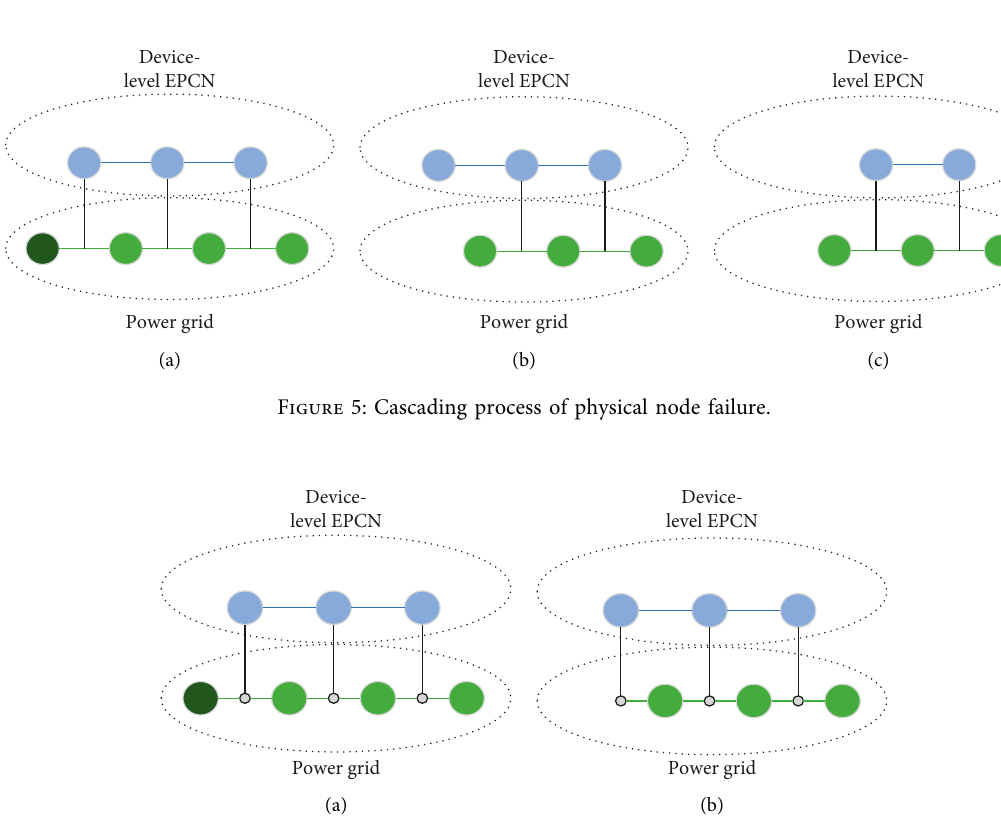
Figure 6: Cascading process with virtual nodes added to physical node